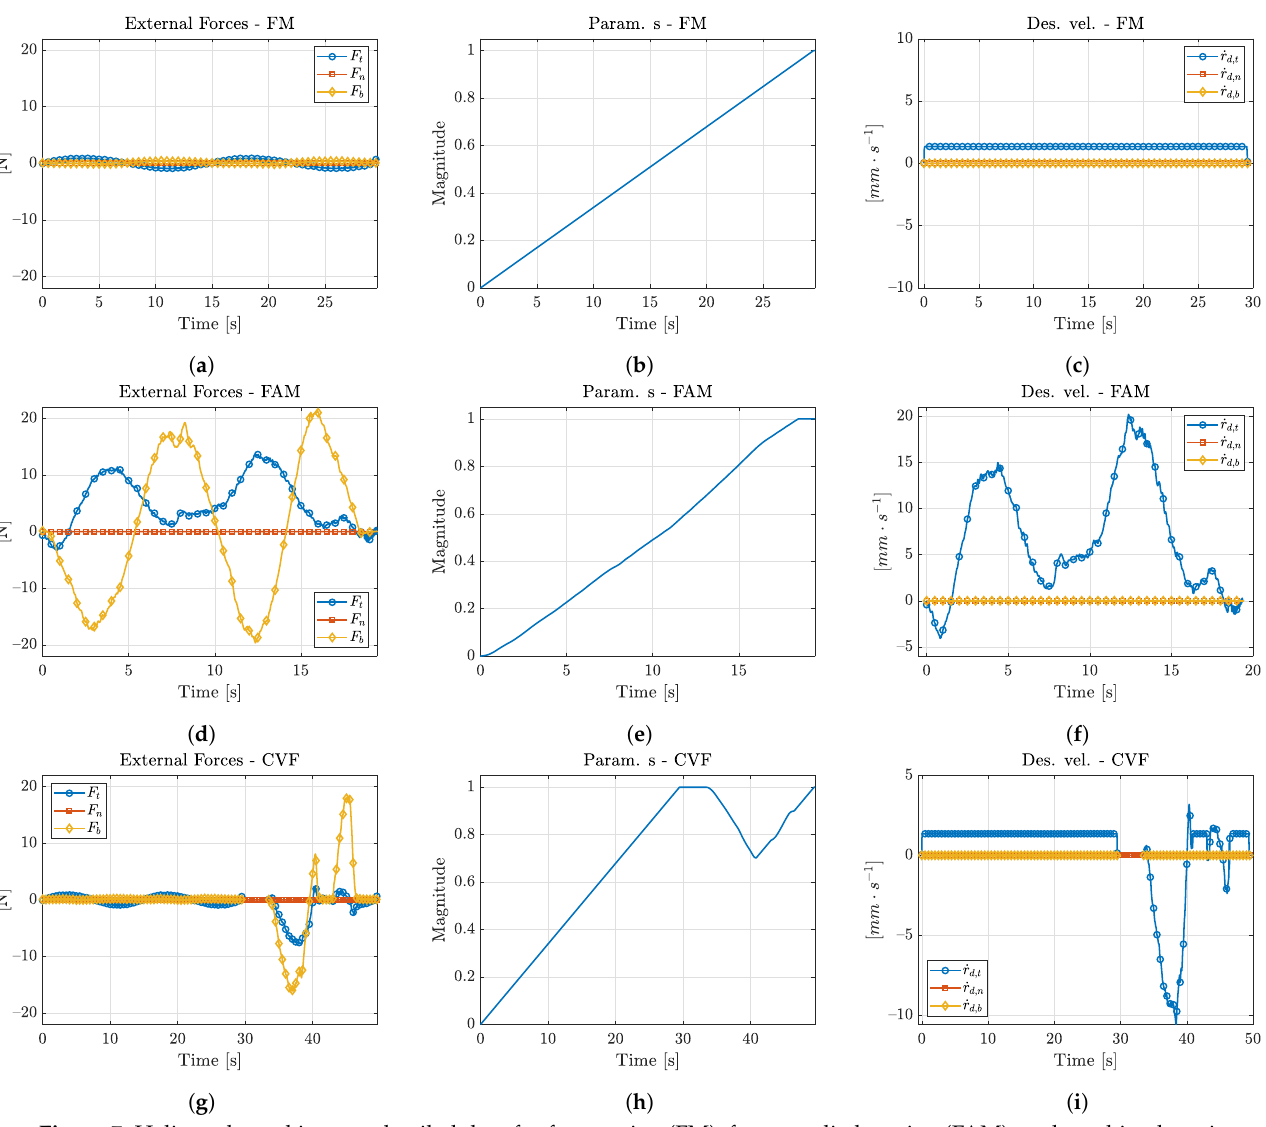
Figure 7. Helix path-tracking test detailed data for free motion (FM), force-applied motion (FAM), and combined motion with virtual forces (CVF) in the TNB frame. ( a ) External Forces-FM. ( b ) Parameter s-FM. ( c ) Desired Velocities-FM. ( d ) External Forces-FAM. ( e ) Parameter s-FAM. ( f ) Desired Velocities-FAM. ( g ) External Forces–CVF. ( h ) Parameter s–CVF. ( i ) Desired